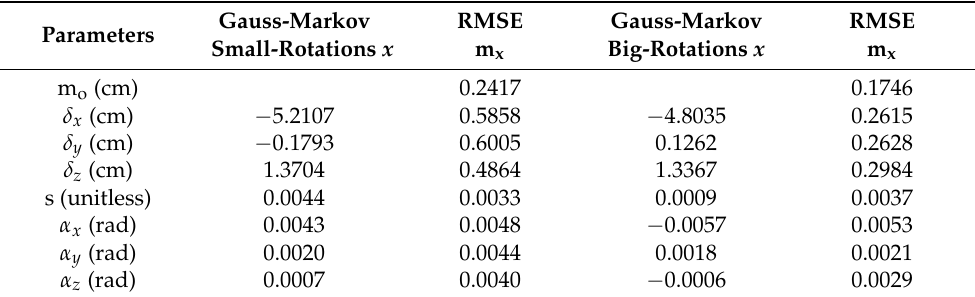
Table 1. Aristotle sculpture: transformation parameters ( x ) with their RMSE ( m x ) in coarse registra- tion with the ISS+PFH method.